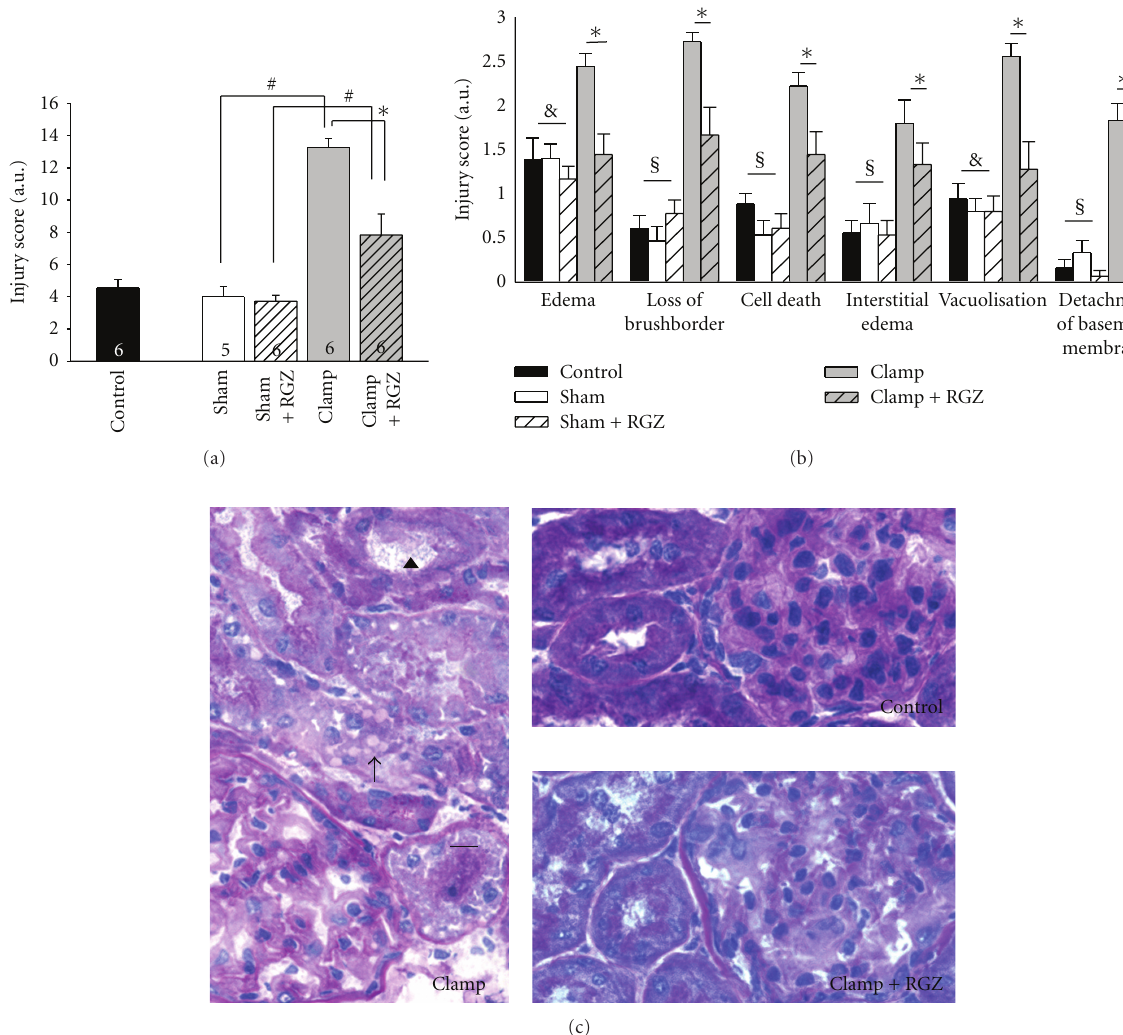
Figure 2: E ff ect of rosiglitazone (RGZ) on morphological alterations in the kidney of Sprague-Dawley rats in renal I/R injury. Renal cryostat sections were stained with periodic acid-Schi ff (PAS). Injury was graded by a score as described in Section 2. (a) Total injury score (mean values from Figure 2(b) were taken together). n as indicated. # , ∗ statistically significant di ff erence as indicated. (b) Single criteria of histopathologic investigations are shown. n from 4 to 6 for each group. ∗ Statistically significant di ff erence ( P < 0 . 05) between clamp versus clamp + RGZ; $ statistically significant di ff erence ( P < 0 . 05) between control, sham, sham + RGZ versus clamp and clamp+RGZ; statistically significant di ff erence ( P < 0 . 05) between control, sham, sham + RGZ versus clamp alone. (c) Representative sections of images of the renal cortex after PAS staining are shown. Control group, clamp group, and clamp + RGZ group as indicated on the sections. Some of the lesion criteria are exemplified. Arrowhead points to loss of the brush border. Arrow shows vacuolization in epithelial cells of the tubuli. Lines without arrowheads show tubular epithelial cells with defragmented